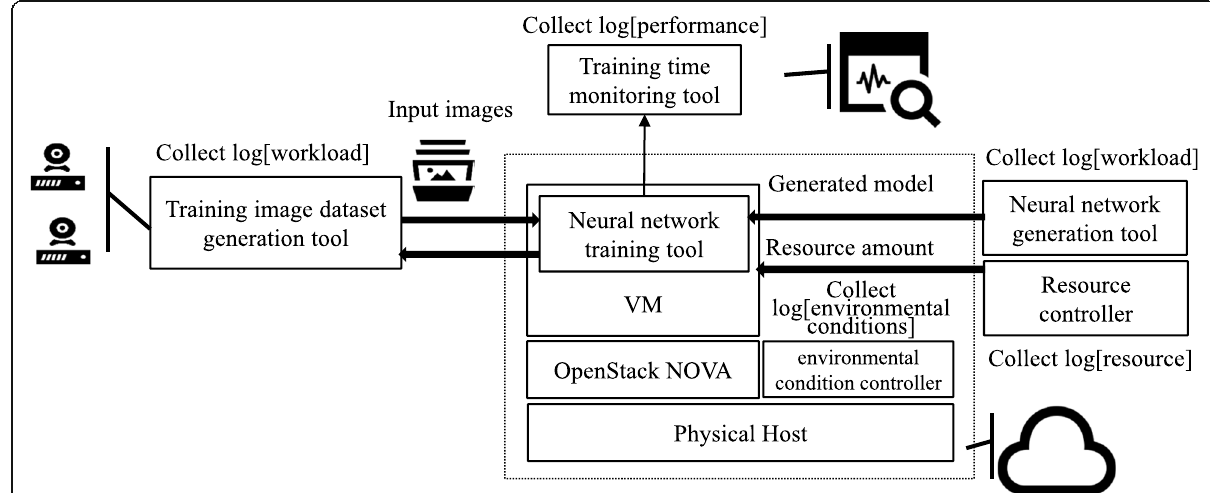
Fig. 5 Experiment setup to simulate the sensor-cloud system